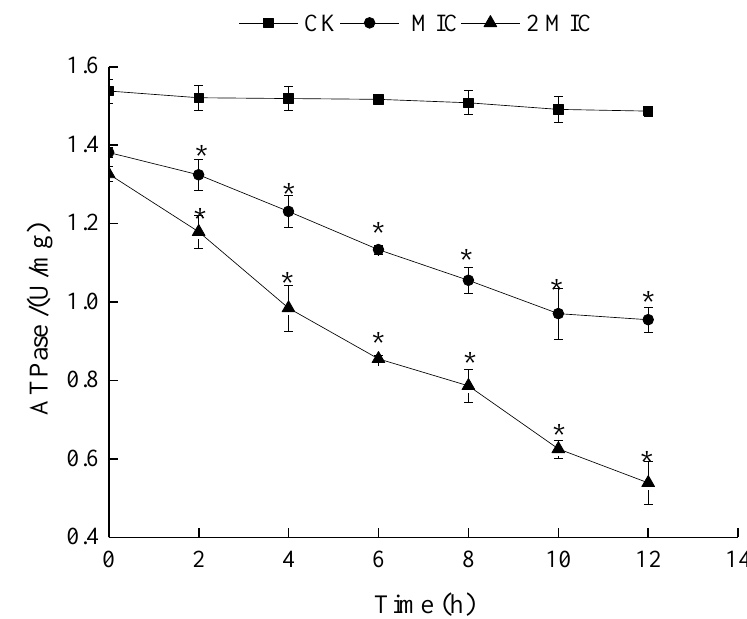
Figure 5. Effects of ε-PL against on ATPase activity of S. putrefaciens . Bars represent the standard error of the means. The superscript (*) indicates a result that is significantly different to the equivalent control point (t test, p < 0.05 ).